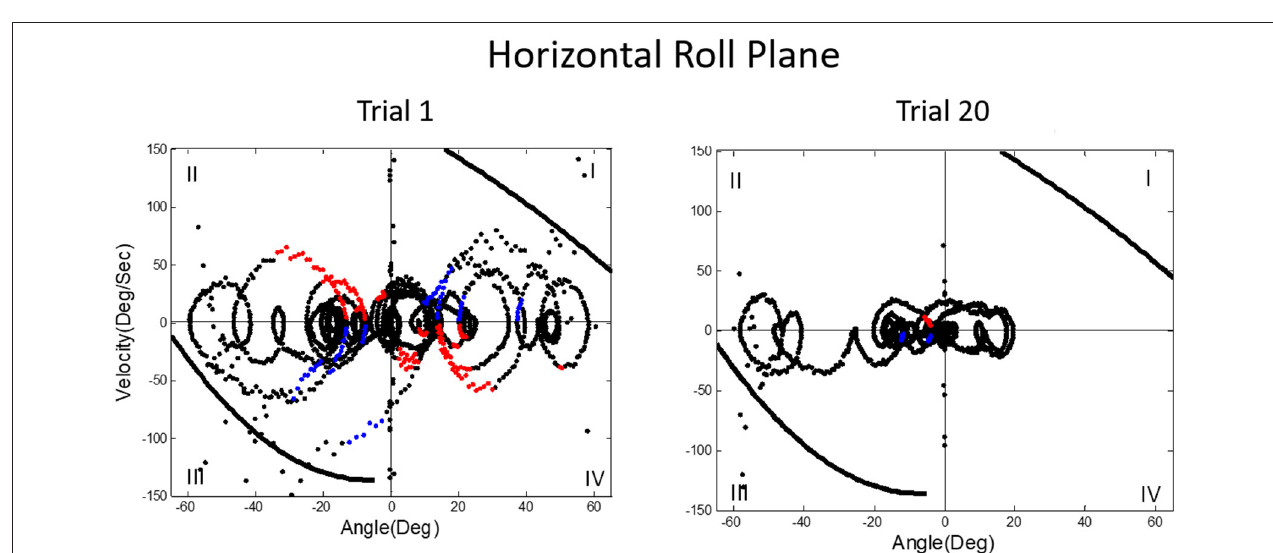
FIGURE 12 | Velocity-position phase plots for a typical subject in horizontal roll plane balancing show cyclical patterns of looping and drifting. The drifting and looping are reduced but not eliminated over repeated trials. Crashes are decreased but not eliminated as shown by dots outside crash